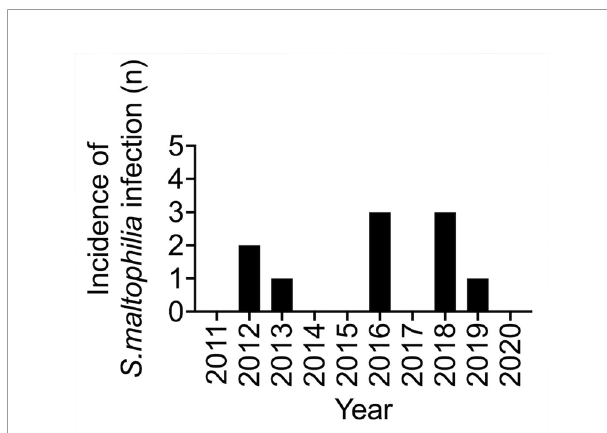
FIGURE 1 | Annual frequency of S. maltophilia infection in children with oncological or hematological disease including patients with autologous or allogeneic hematopoietic cell transplantation between 2011 and 2020. For 2020, cases until March are included. p = 0.34 for the comparison of the proportion of S. maltophilia blood strem infections (BSI) (n = 9) among all BSIs in 2016-2020 relative to 2011-2015 (n.s.).